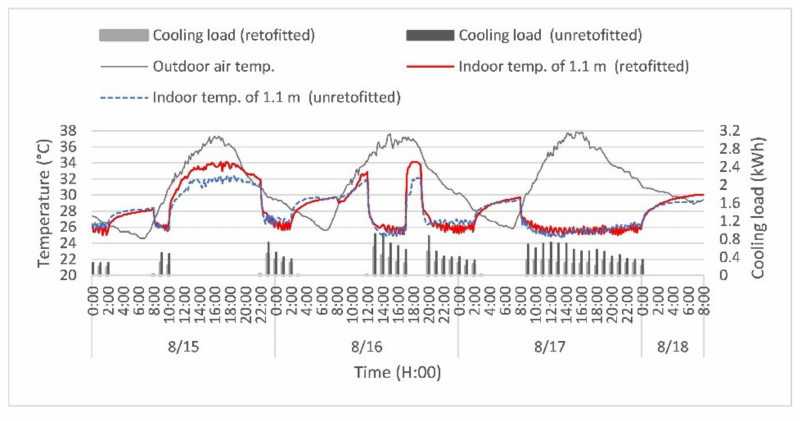
Figure 16. Comparison of indoor temperature and hourly cooling load at 1.1 m.